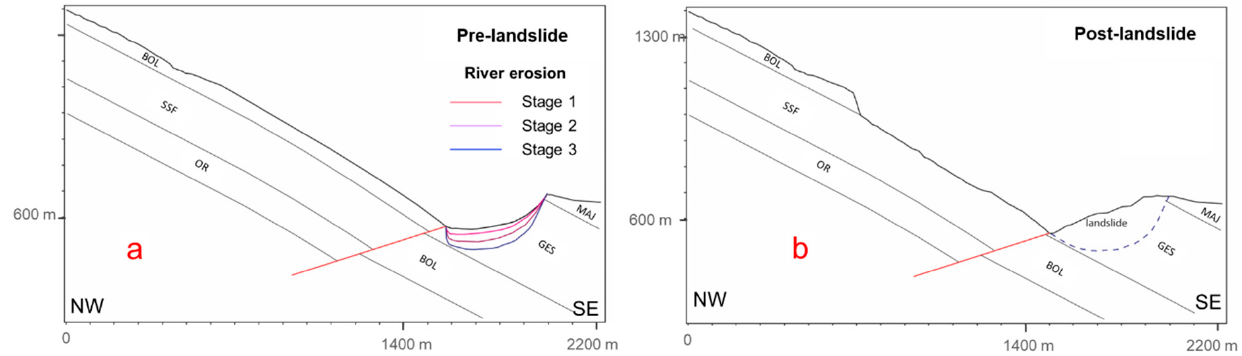
Figure 4. Geological models of the analysed slope with the consideration of the effect of sequential river incisions, ( a ) pre-landslide, ( b ) post-landslide.